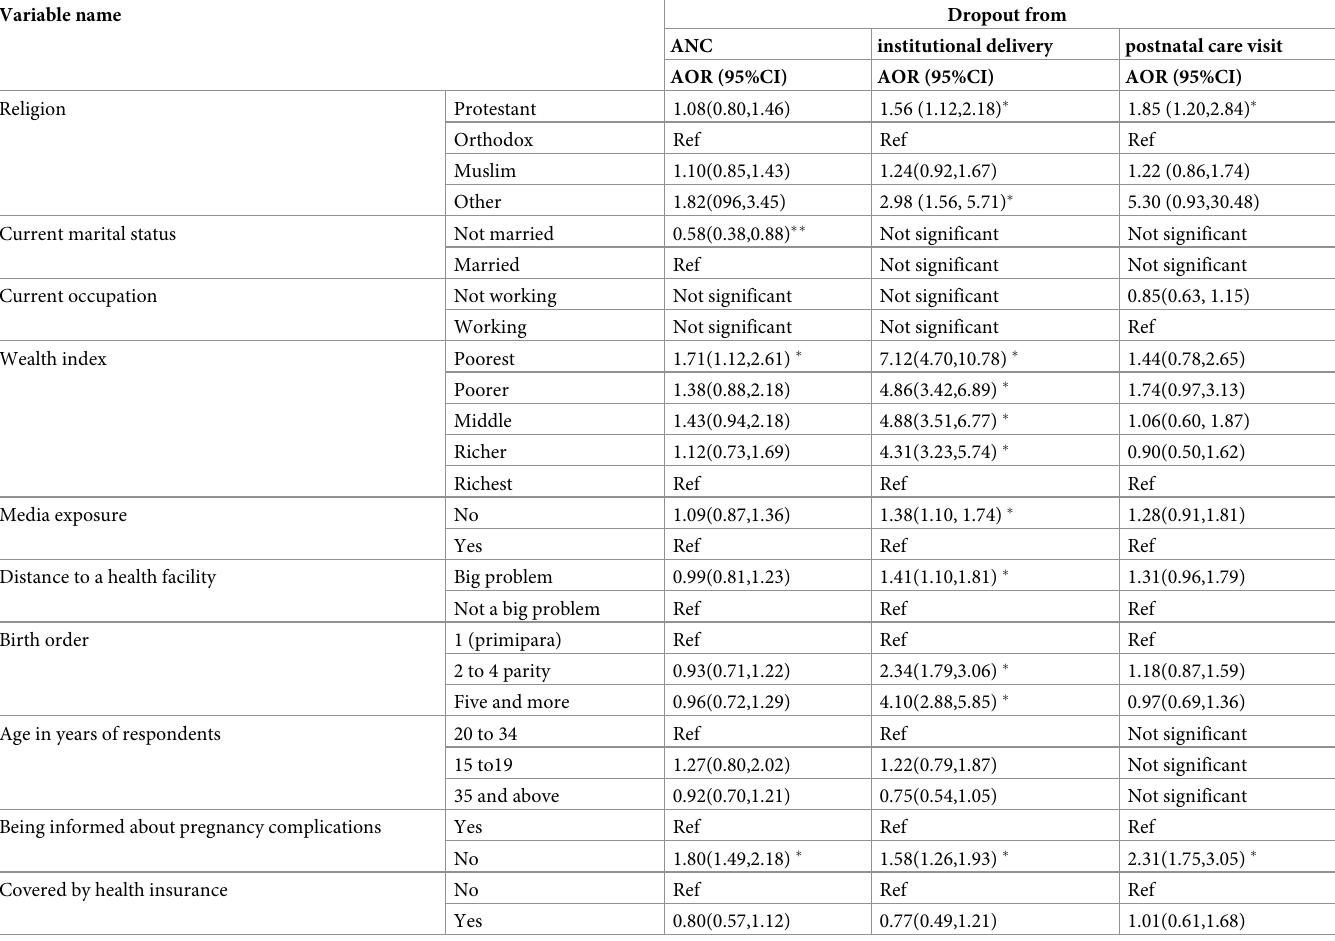
Table 4. Factors associated with a dropout of maternity continuum of care among reproductive-age women in Ethiopia, 2016 EDHS